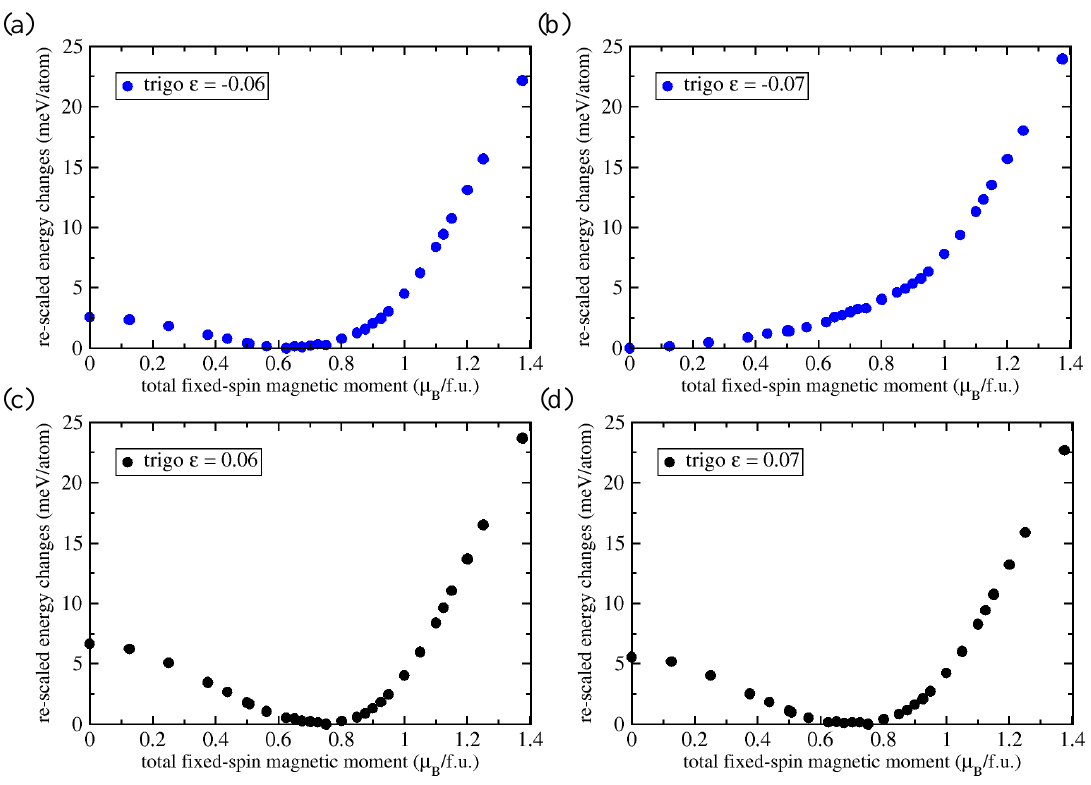
Figure 3. Ab initio calculated energies of trigonally deformed Fe 2 AlTi for different values of fixed-spin moment (FSM). Results are shown for selected values of strain ε including negative ( a ) − 0.06 and ( b ) − 0.07 and positive ( c ) 0.06 and ( d ) 0.07. The energies for each value of ε and different values of FSM are shown as differences with respect to the lowest energy for a given value of ε